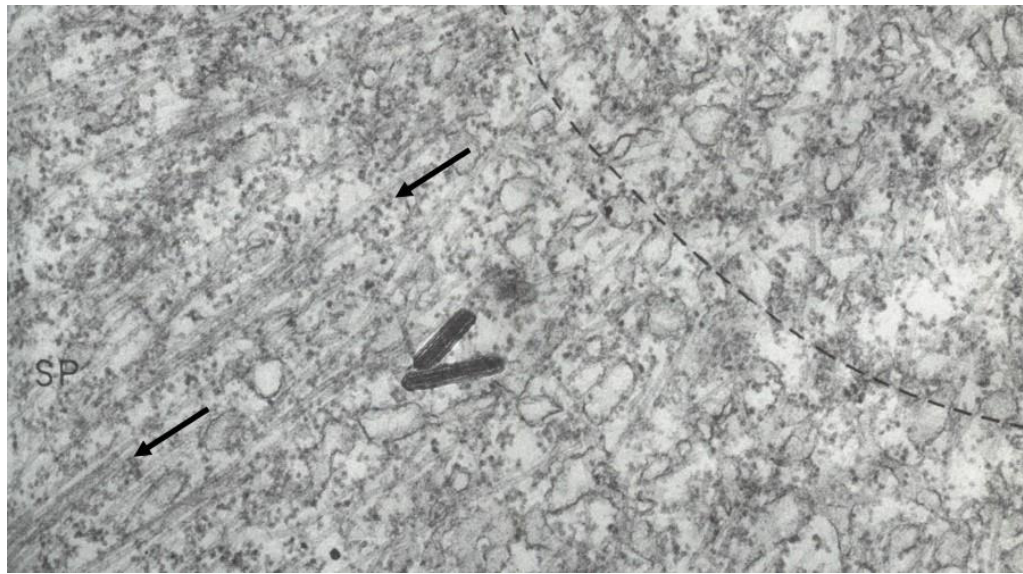
Figure 7. A portion of a sea urchin mitotic spindle (SP) imaged in an electron microscope, showing the MTs (arrows) that make up the spindle fibers that had been seen by light microscopy. The curved dashed line marks the polar end of the spindle and the beginning of a specialized region that surrounds the spindle pole in these cells. (Dark rods are contamination.) Harris, 1965 [30]. This image is displayed under the terms of a Creative Commons License (Attribution-Noncommercial-Share Alike 3.0 Unported license, as described at http://creativecommons.org/licenses/by-nc-sa/3.0/.